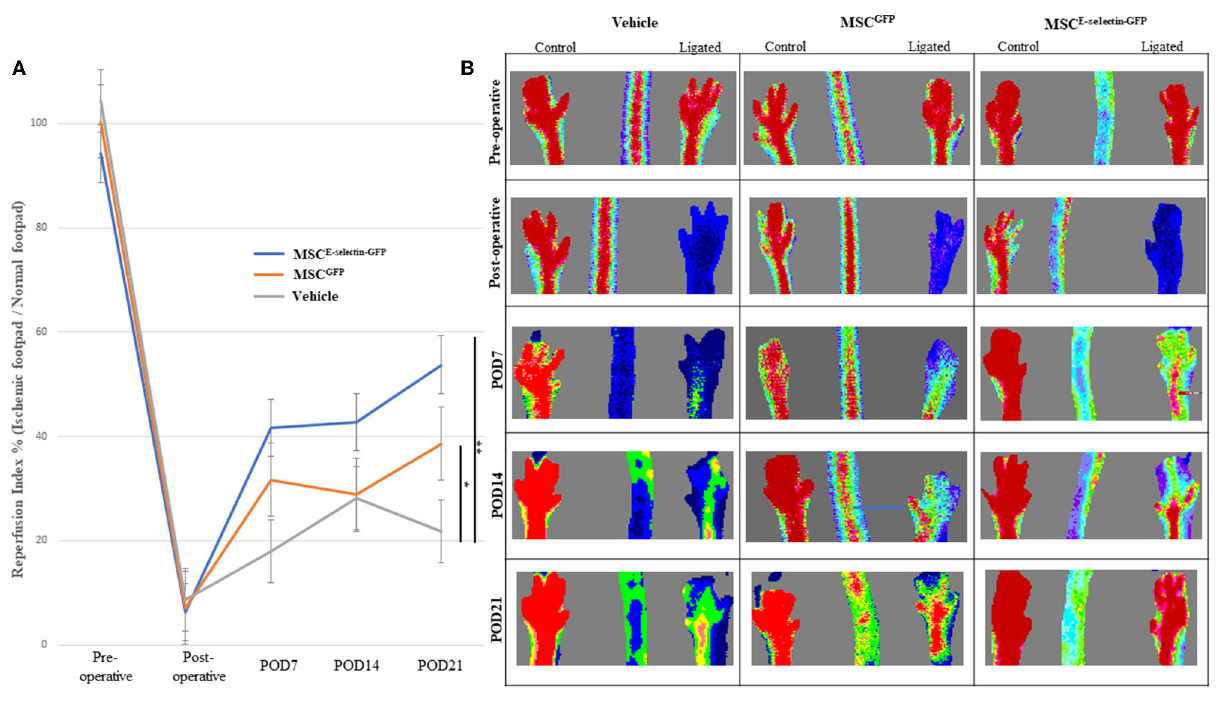
FIGURE 3 | MSC E − selectin − GFP treatment increases ischemic limb reperfusion. (A) The quantitative analysis of limb reperfusion measured by LDI (reperfusion index % = ischemic ligated footpad/normal control footpad, mean ± SD; ** P < 0.01 by ANOVA and * P < 0.05 by post-hoc analysis, Vehicle n = 6, MSC GFP n =